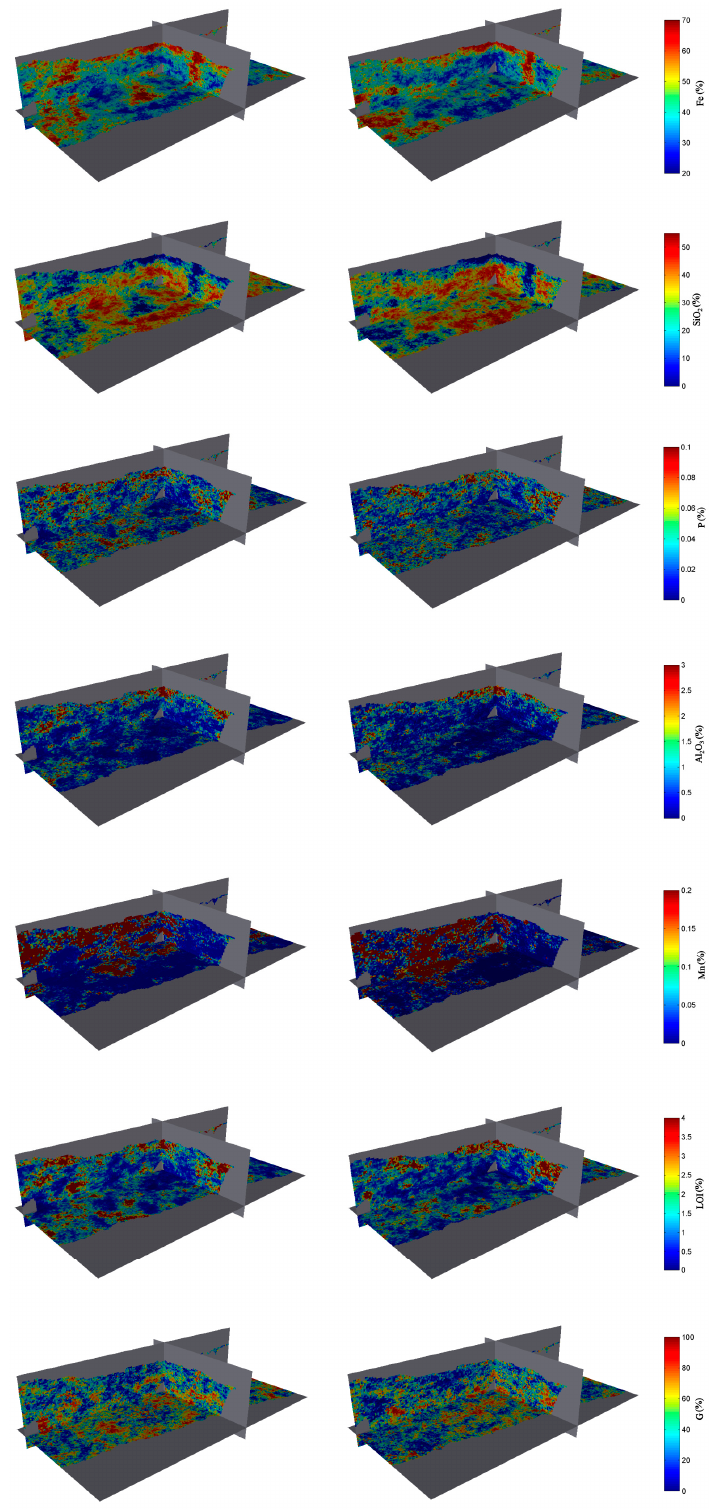
Figure 4. Isometric view of two realisations of the grades and granulometry ( left : realisation 1 and right : realisation 2), showing the plan view and vertical cross-sections passing through the origin (local coordinate system). Waste and air are shown in grey. From top to bottom: iron grade, silica grade, phosphorus grade, alumina grade, manganese grade, loss on ignition, granulometry.